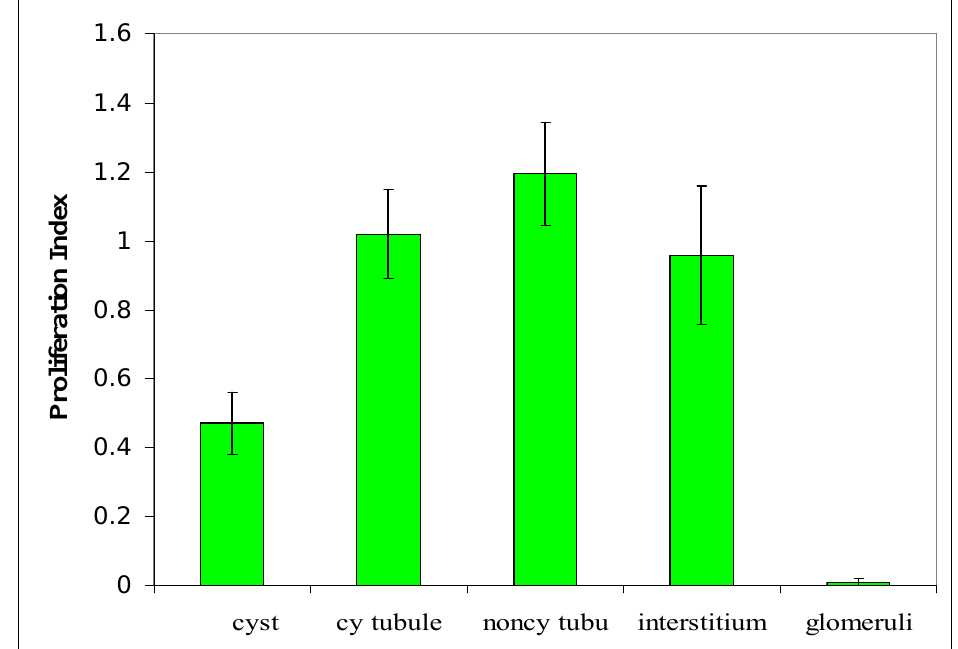
FIGURE 2 The PI in ADPKD tissues (mean ± SEM).